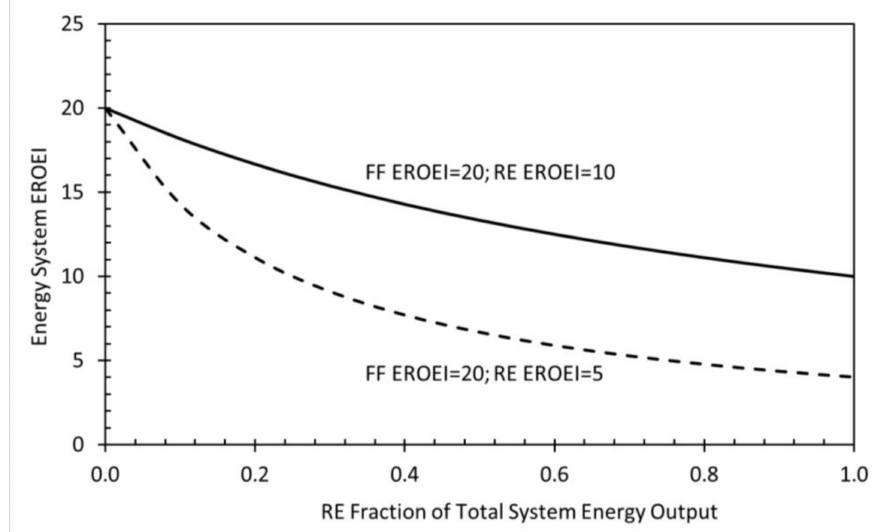
Figure 2. Energy system energy return on energy invested (EROEI) for a fixed fossil fuel (FF) EROEI of 20 and renewable energy (RE) EROEI values of 10 and 5 as a function of RE in the total system energy